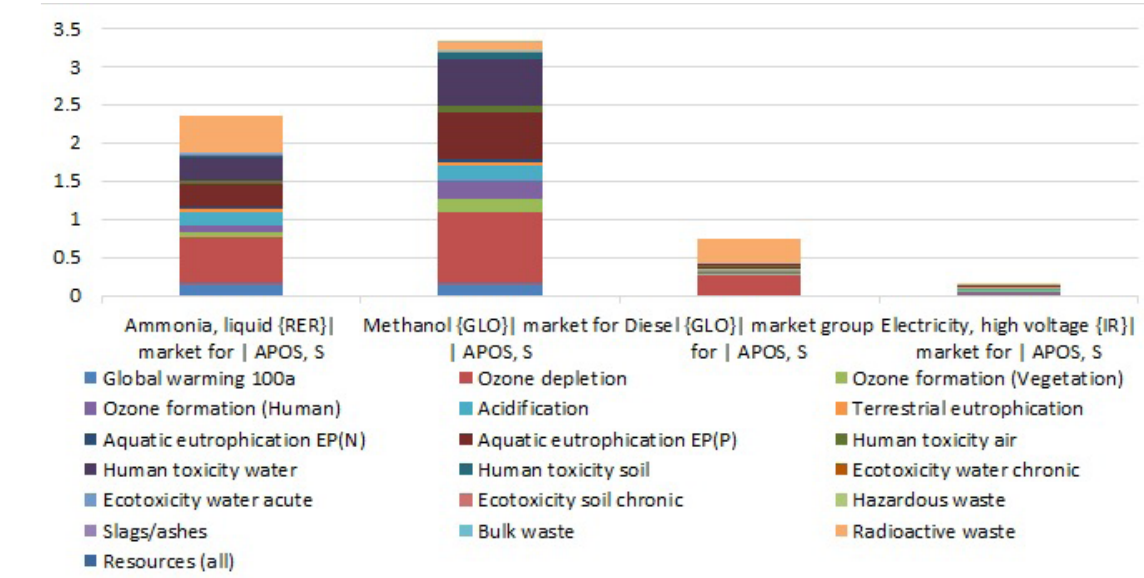
Figure 10. Final environmental points (single score) of life cycle scores using the EDIP 2003 method